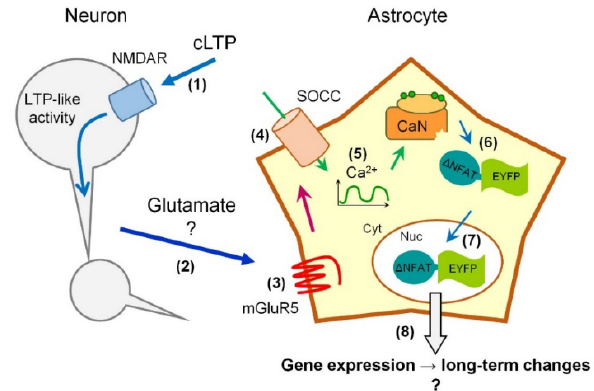
Figure 7. Model of LTP-like neuronal activity-induced CaN activation in astrocytes. LTP-like neuronal activity, possibly through activation of NMDA receptors ( 1 ) and glutamate release form neuronal terminals ( 2 ), induces Ca 2+ entry through the plasma membrane of adjacent astrocytes, possibly implicating astrocytic mGluR5 receptors ( 3 ). The Ca 2+ entry occurs through Orai1-containing SOCE channels (SOCC) ( 4 ) resulting in delayed long-lasting Ca 2+ transients ( 5 ) and activation of CaN inside the astrocytes ( 6 ), which, in turn, leads to nuclear translocation of CaN sensor NY ( ∆ NFAT-EYFP) ( 7 ). The latter event is quantified as an increase in ratio between NY fluorescence in the nucleus (Nuc) and the cytoplasm (Cyt). Increase in CaN activity in astrocytes may lead to transcriptional remodeling and long-term changes ( 8 ). “?“ in ( 2 ) and ( 8 ) indicates questionable points.